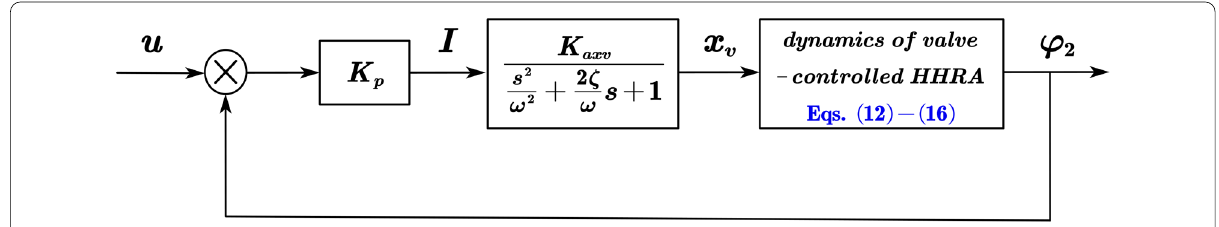
Figure 6 Block diagram of angle closed-loop